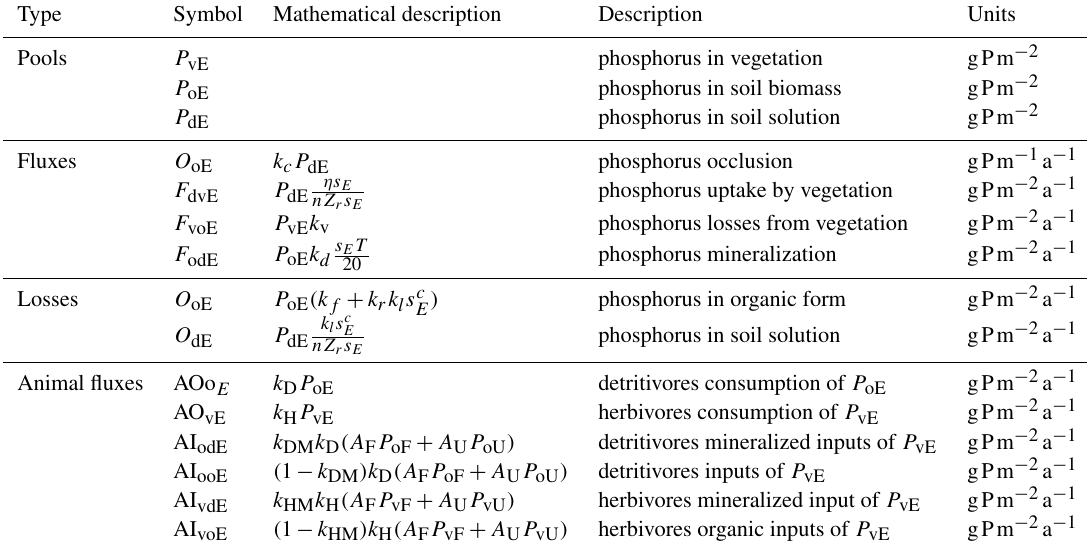
Table 1. Description of symbols. Subscript E may stand for either terra firme (replaced by U) or seasonally flooded ecosystem (replaced by F).